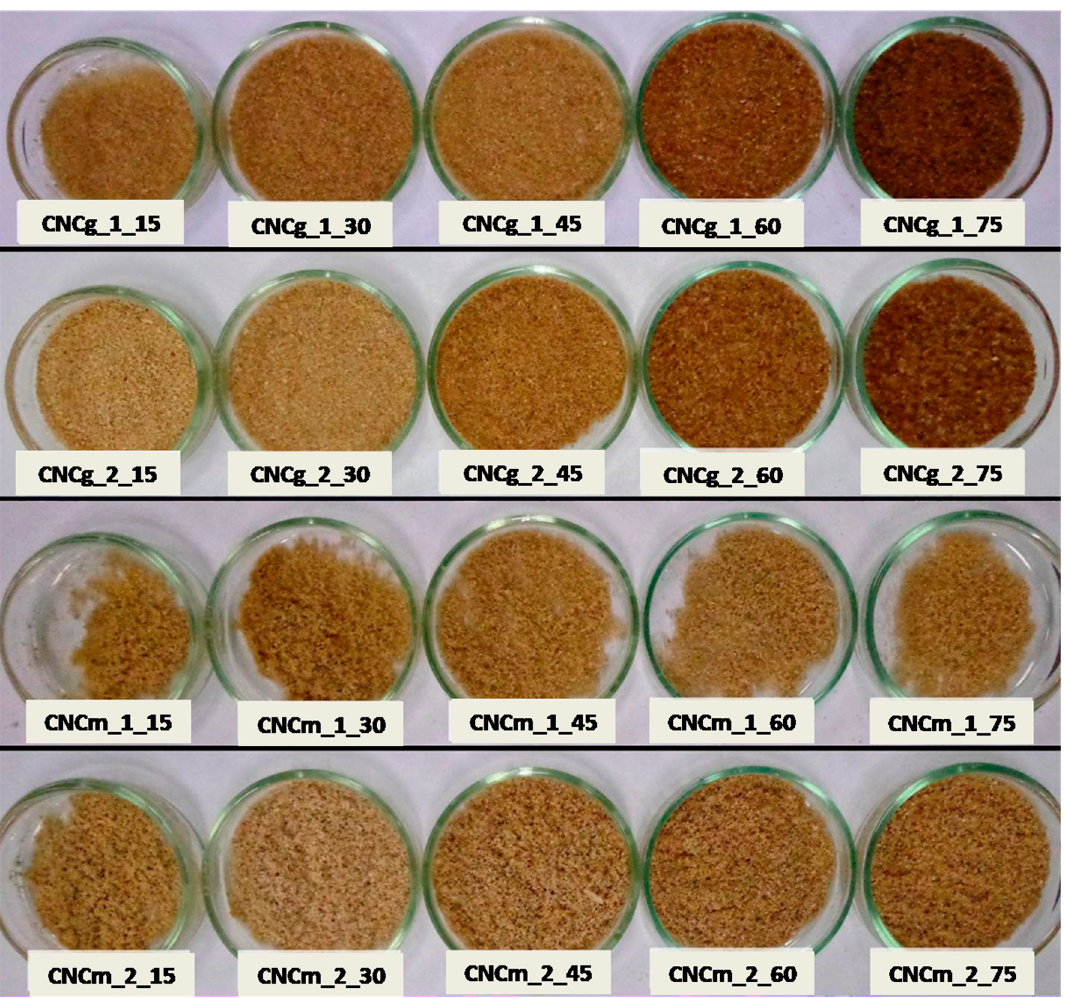
Figure 7. Visual aspect of CNCs from gravata and macauba fibers, after different times of acid hydrolysis and freeze-drying, with their respective encodings.